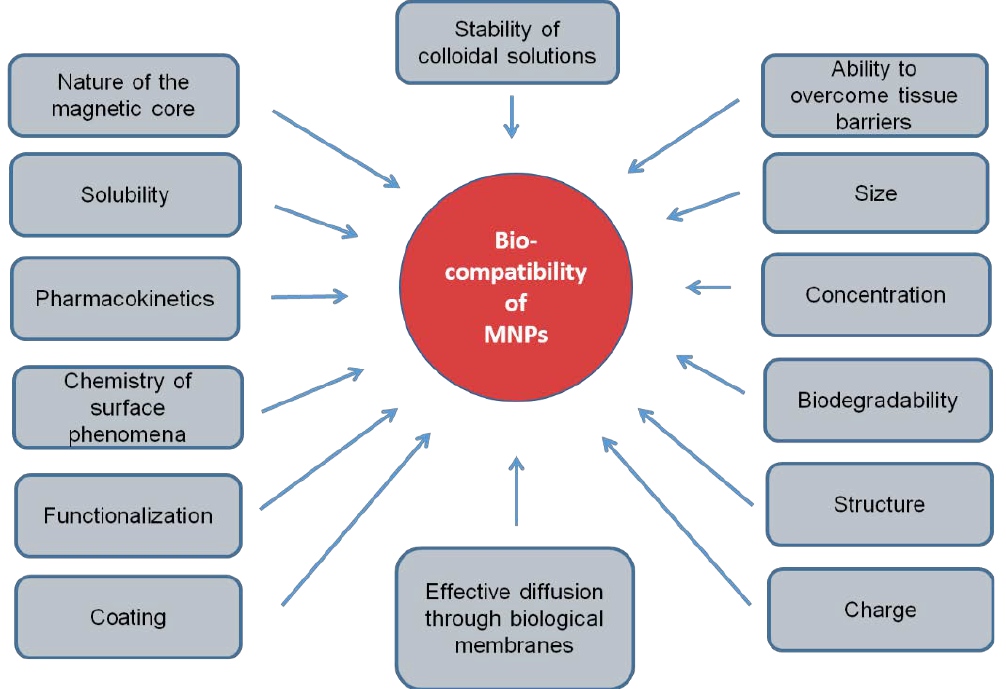
Figure 1. Physical and chemical factors of magnetic nanoparticles, determining their biocompatibility.